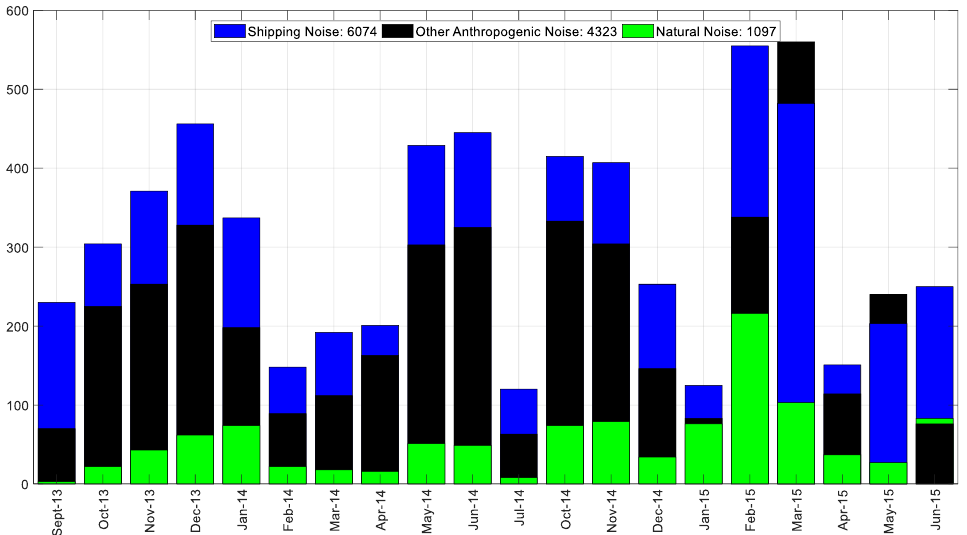
Figure 6. Number of measurements per month classified into three groups: shipping, other anthropogenic, and natural noise measurements. The main source of underwater acoustic pollution in the study area was shipping